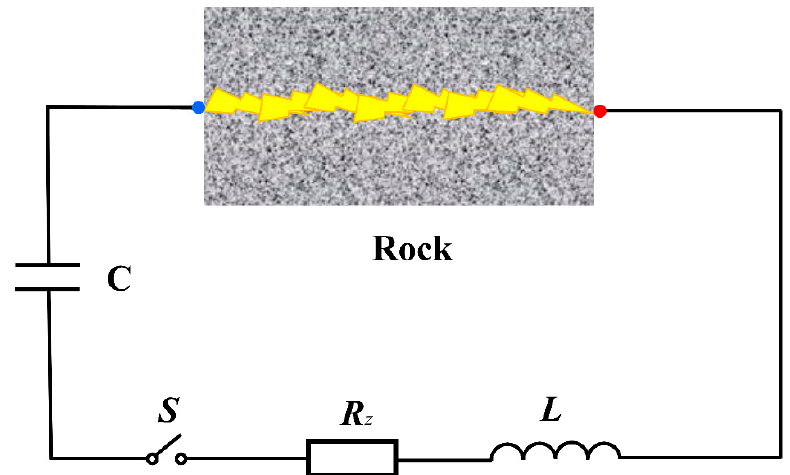
Figure 4. Simplified RLC circuit for electric pulse rock: S —high-voltage pulse switch; R z —resistance of the discharge device; C —capacitor; L —inductive inductance; Rock—the rock under electropulse.